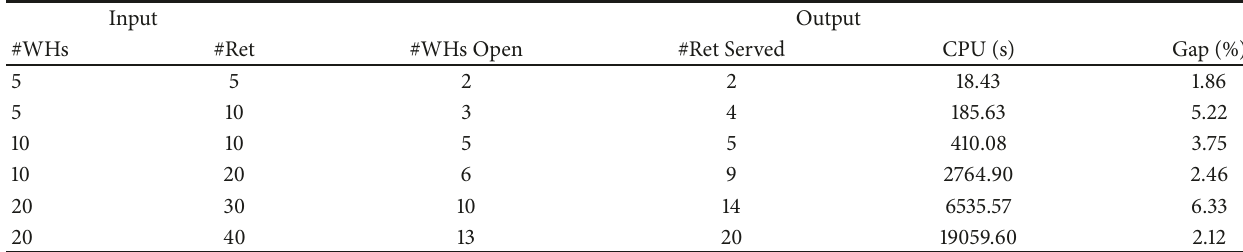
Table 4: The computational results for P with small capacity.